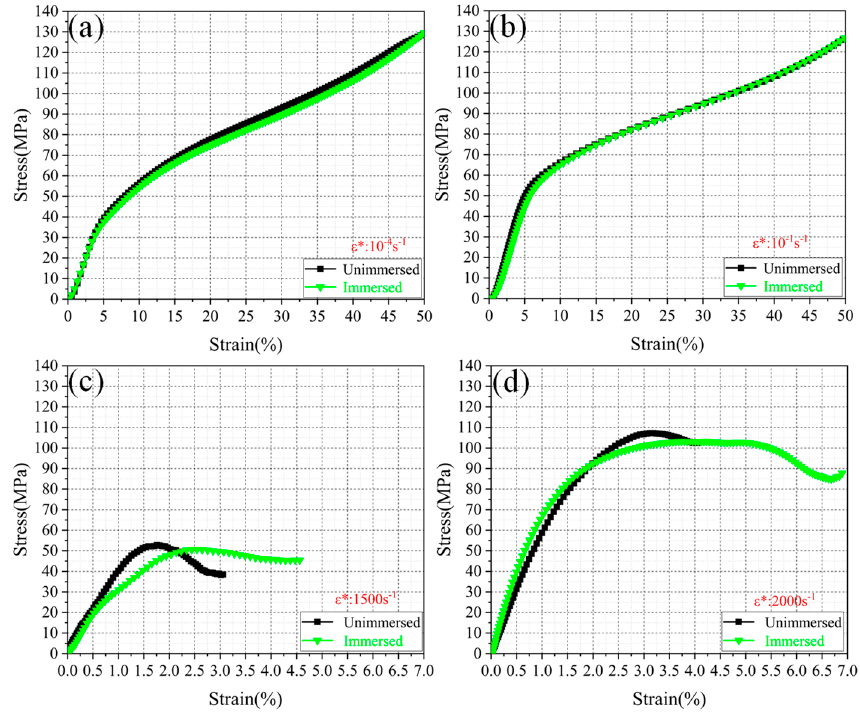
Figure 9. The stress–strain curves of SLS of CF/PA12 under different strain rates: ( a ) 10 -4 s -1 ; ( b ) 10 -1 s -1 ; ( c ) 1500 s -1 ; ( d ) 2000 s -1 .